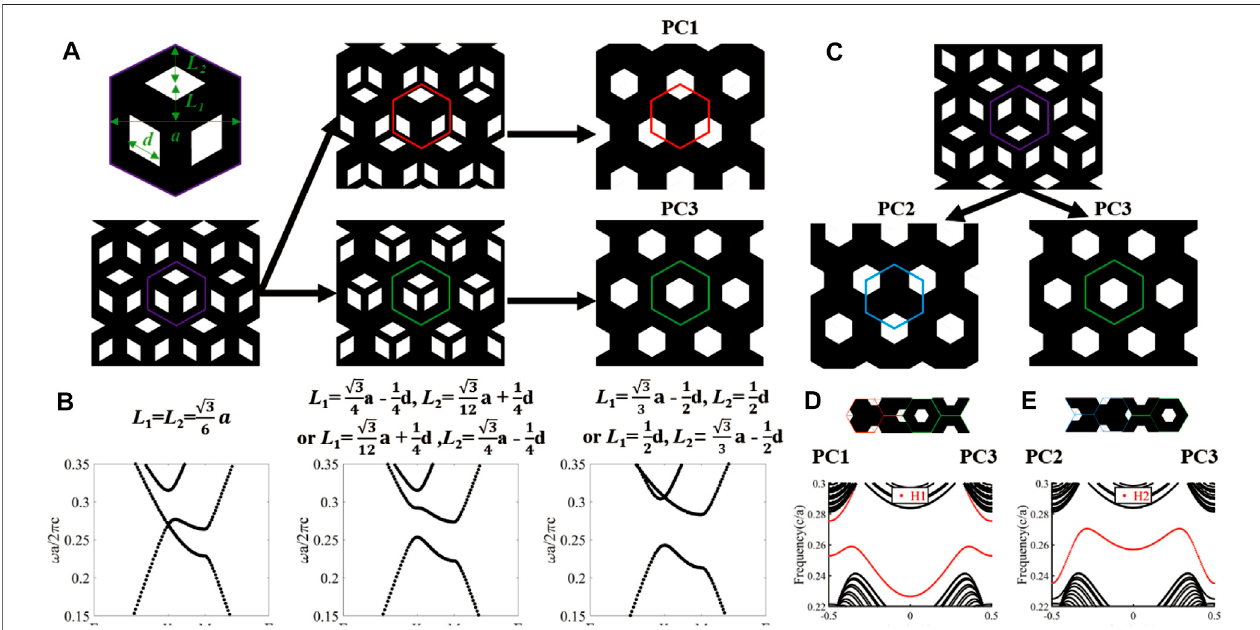
FIGURE 2 | Design of the second-order topological photonic crystal in Kagome lattice. (A) The evolution of Kagome-lattice photonic crystals (PCs) with the assignment of Δ -shape cluster and (B) the corresponding TE-polarized band structures. The unit cell of Kagome-lattice PC with lattice constant a consists of three rhombic-pro fi le air holes as a cluster, where the side length of the rhombic hole d = 0.28 a . L 1 is the distance from the center of the rhombic hole to the center of the unit cell, and L 2 is the distance from the center of the rhombic hole to the vertex of the unit cell. Starting from L 1 = L 2 , the intra-cluster coupling strength is equivalent to the inter-cluster case and there was a degenerate point around the K point of bulk band structures. With the expansion and shrinkage of clusters, the degenerate point disappears and the two bands gradually opened to form a TE-polarized gap. (C) The evolution of Kagome-lattice PCs with the assignment of ▽ -shape cluster. We can have the same shrunken PC (i.e., PC3) and another expanded PC (i.e., PC2). (D,E) Schematics of two types of interfaces and their edge dispersions (labeled as H1 and H2). The red points represent the edge states, while the black points represent bulk